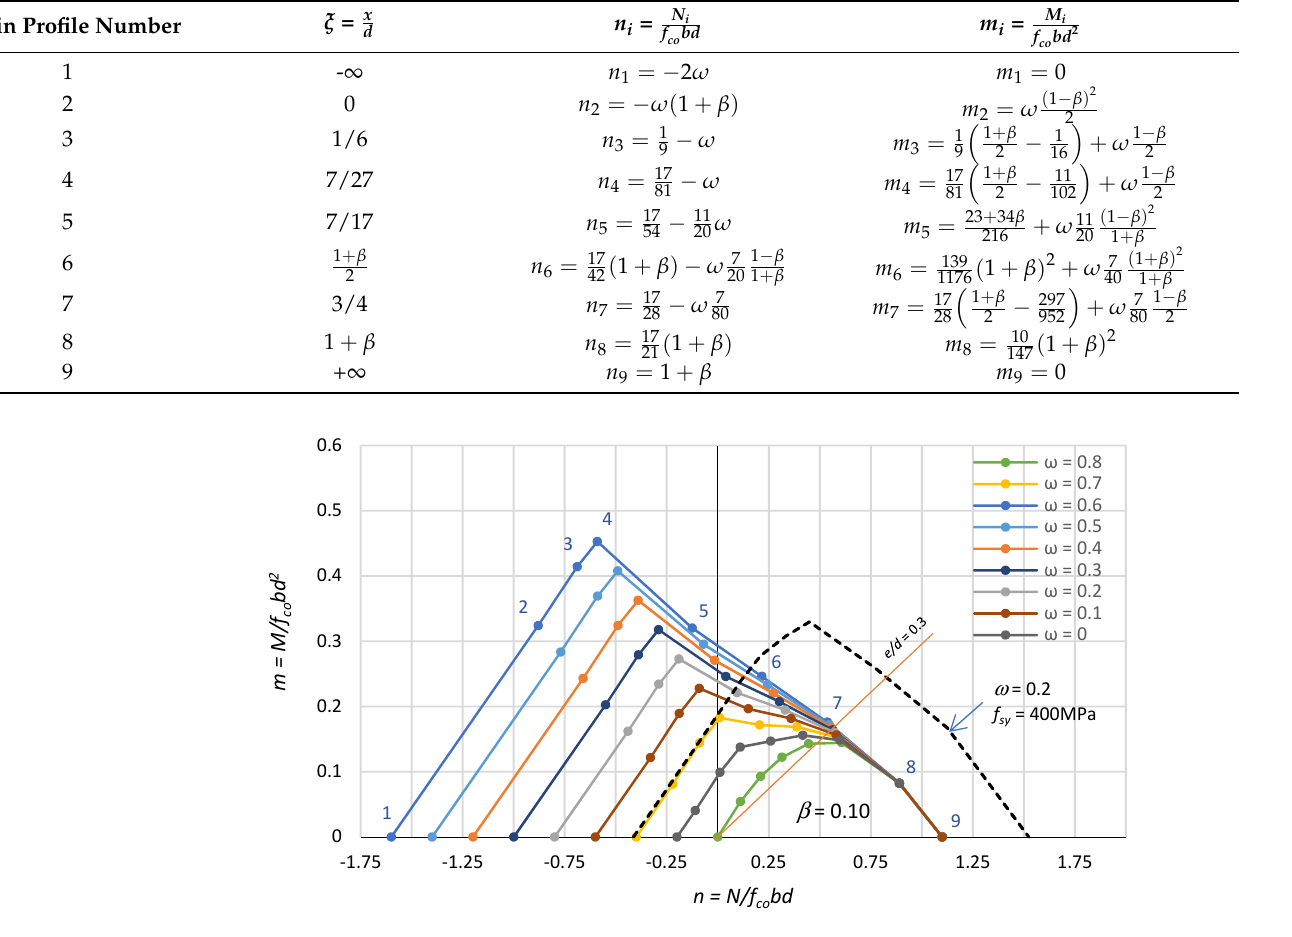
Figure 7. Effect of the mechanical reinforcement ratio ω on the interaction n–m without the compression bars.